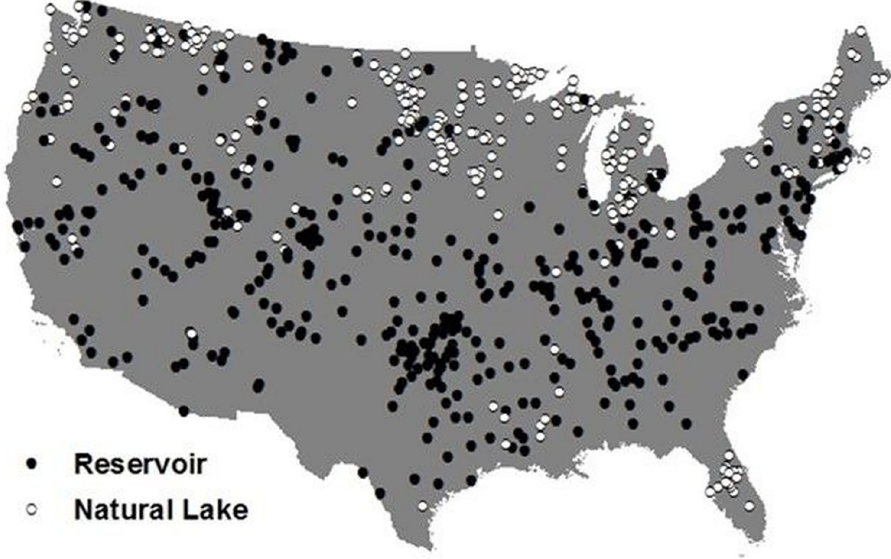
Fig 1. Locations of reservoirs (filled circles) and natural lakes (open circles) sampled in the 2007 National Lakes Assessment that were included in zooplankton analyses.